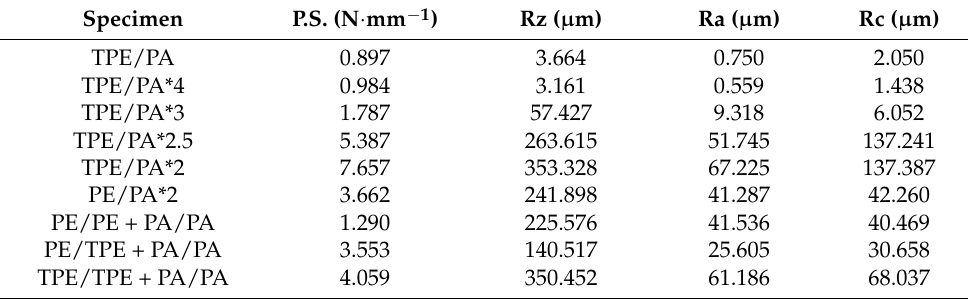
Table 3. The results of roughness parameters obtained by light